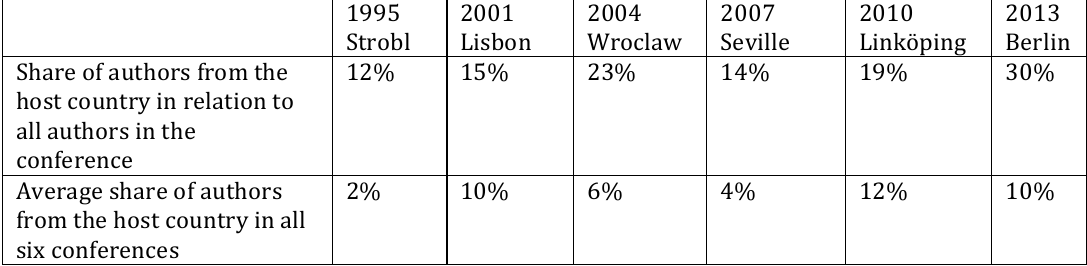
Table 2: ESREA conferences and the shares of authors from host countries